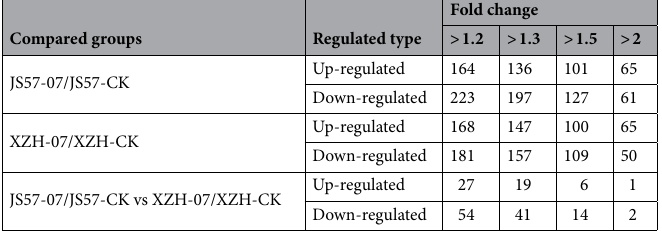
Table 1. Differentially expressed protein in the comparisons ( p value <